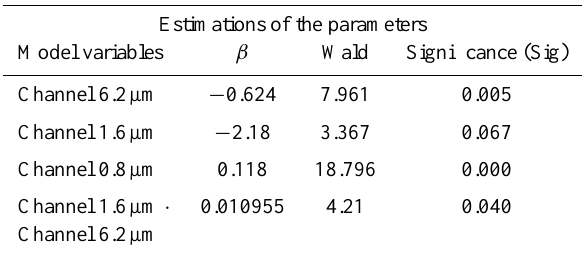
Table 5. Parameters selected by logistic regression for HM: metric explanatory variables input to the model, β coefficients used to ex- tract the sign, and Wald parameter used to compute the weight. The symbol “ · ” represents multiplication between